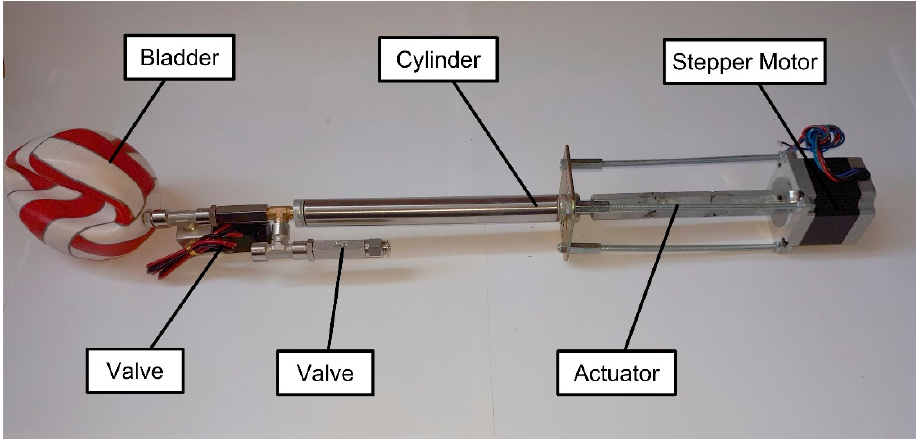
Figure 5. Buoyancy engine prototype.